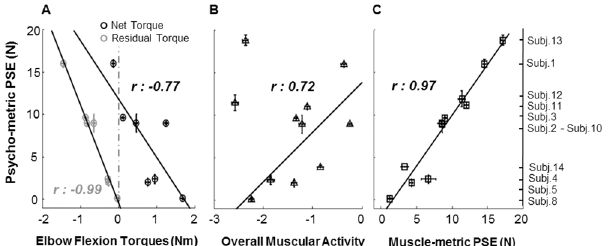
Fig 6. Individual psychometric thresholds as function of individual elbow joint torques, overall muscular activity and muscle-metric PSE. A) Individual median ( ± S.E.) of net (black) and residual (gray) elbow flexion torques as function of individual psychophysical PSE ( ± S.E.) of those subjects that respected goodness of fit criteria and joint torques were extracted. Residual torque values were obtained by removing the gravitational component from the total net torque. Negative torques indicate downward resultant joint torque. Positive values represent resultant upward joint torques. Continuous lines and r values are the best fitting regression line and the resultant Pearson correlation through the data points, respectively. B) PSE values as function of individual overall muscular activity calculated by extracting the median of the sum of the normalized MAV value among muscles at each trial for all subjects showing R² merged > 0.5. Negative values indicate main flexor overall muscular activity, while positive represent overall extensor activity. Pearson correlation and best fitting regression line were extracted excluding subject 12 and 13. C) Correlation among individual psychophysical PSE ( ± S.E.) and PSE ( ± S.E.) extracted from muscle-metric curve (same data as in Fig 4). In all plots, r values represent statistically significant Pearson correlation ( p <